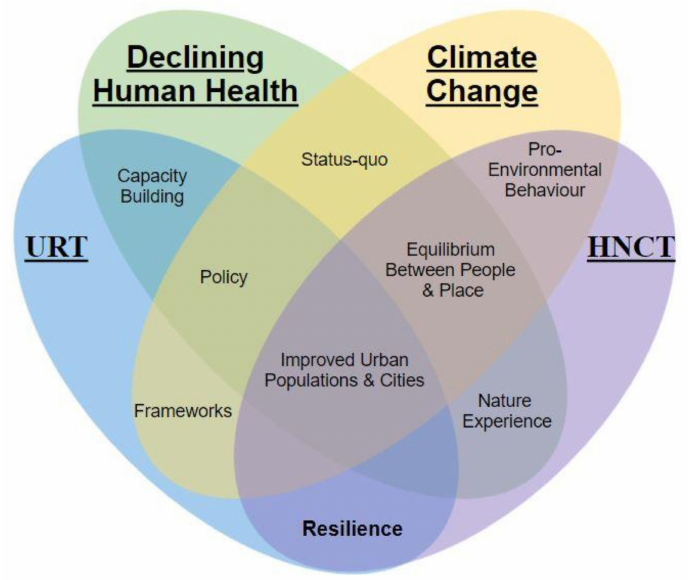
Figure 1. Conceptual model of the interrelationships between the twin crises of climate change and declining human health in urban centers and mitigation and mediation measures o ff ered by the Urban Resilience Theory (URT) and the Human-Nature Connection Theory